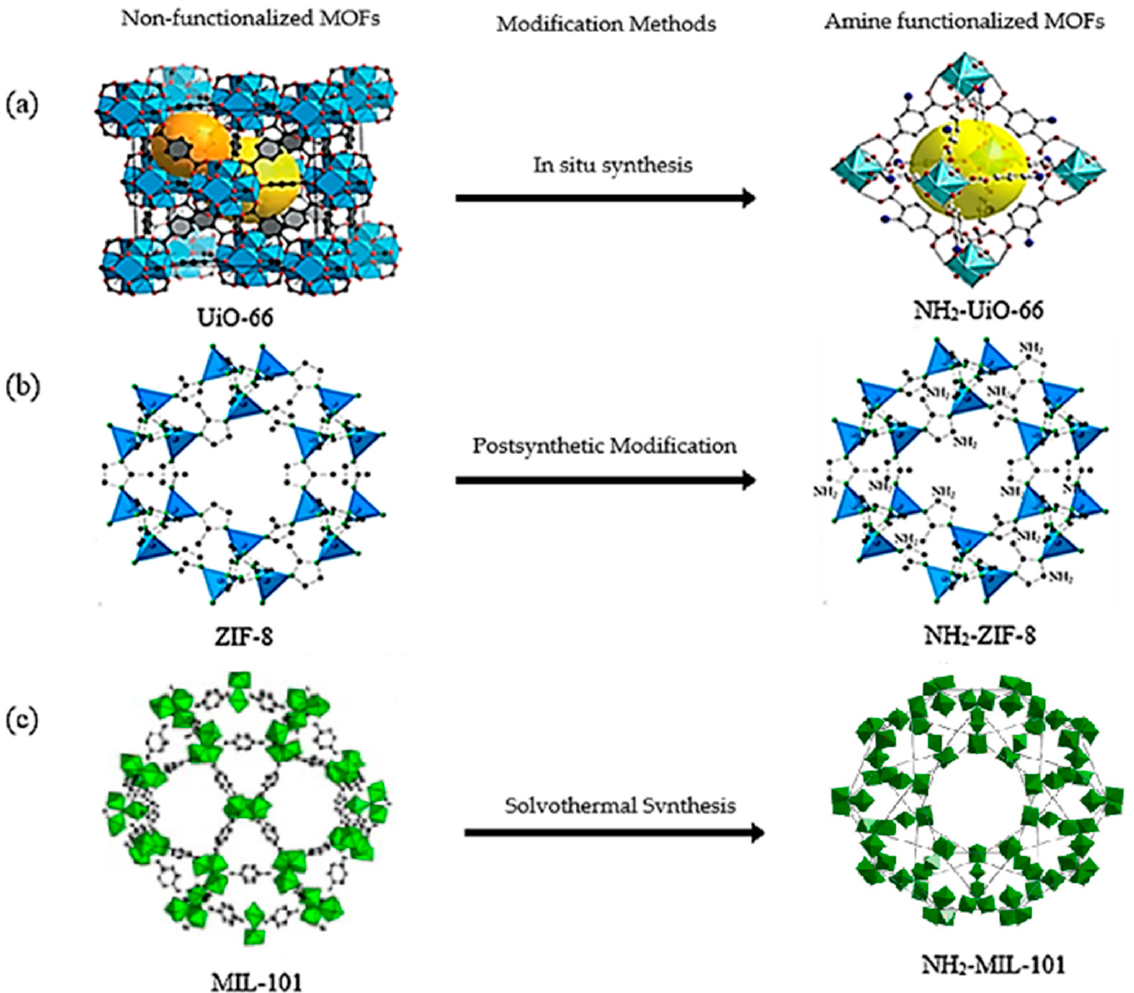
Figure 2. Schematic diagram of MOFs: ( a ) UiO-66 and NH 2 -UiO-66, ( b ) ZIF-8 and NH 2 -ZIF-8, ( c ) MIL-101 and NH 2 -MIL-101 [74–78].